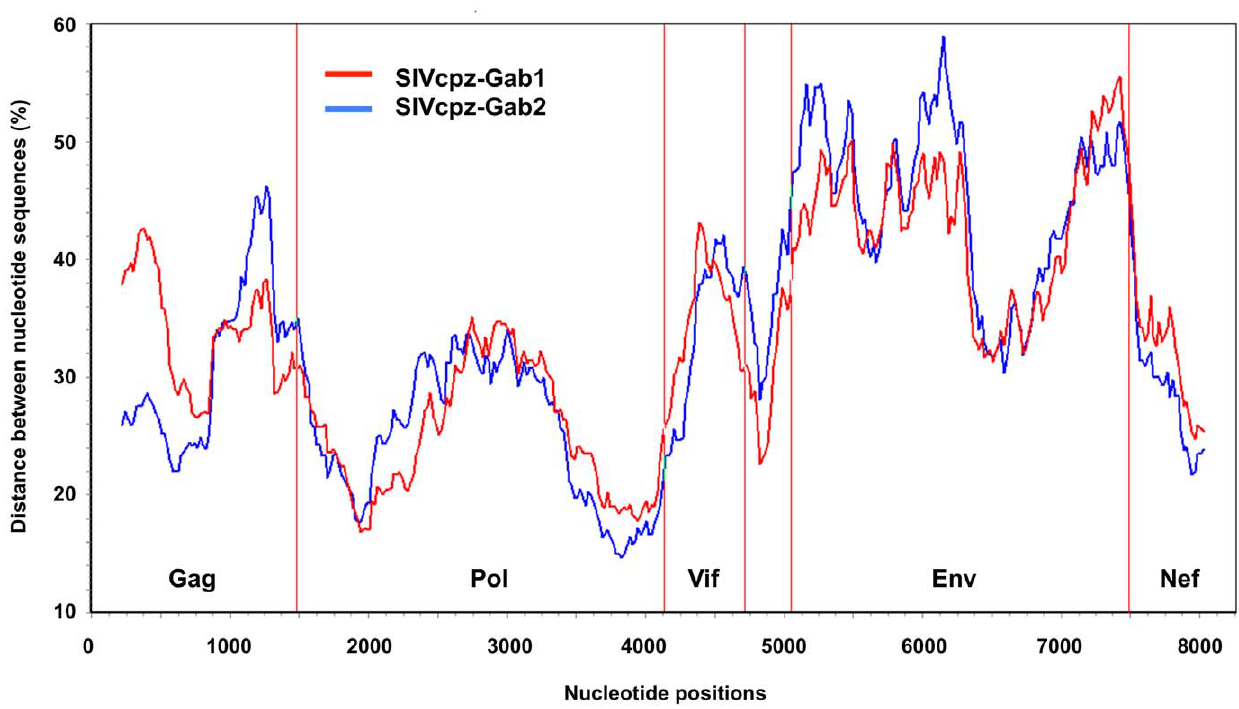
Figure 4. Diversity plot of SIVcpz-Gab4 with SIVcpz-Gab1 and SIVcpz-Gab2 sequences. Regions with uncertain aligment or sites with a gap in any sequence were excluded (8261 nucleotides after de-gapping). The nucleotide sequence difference is plotted for windows of 450 nucleotides and a 20-nucleotide step increment.